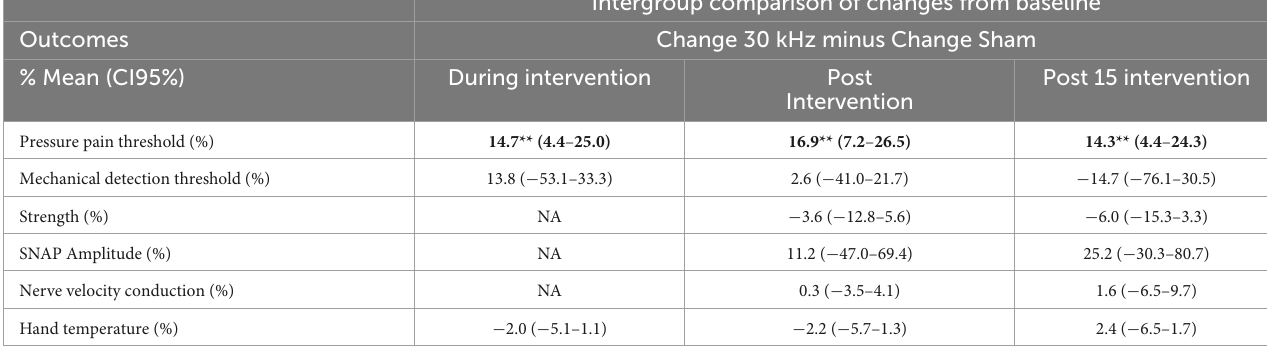
TABLE 3 Intergroup comparison of changes from baseline.